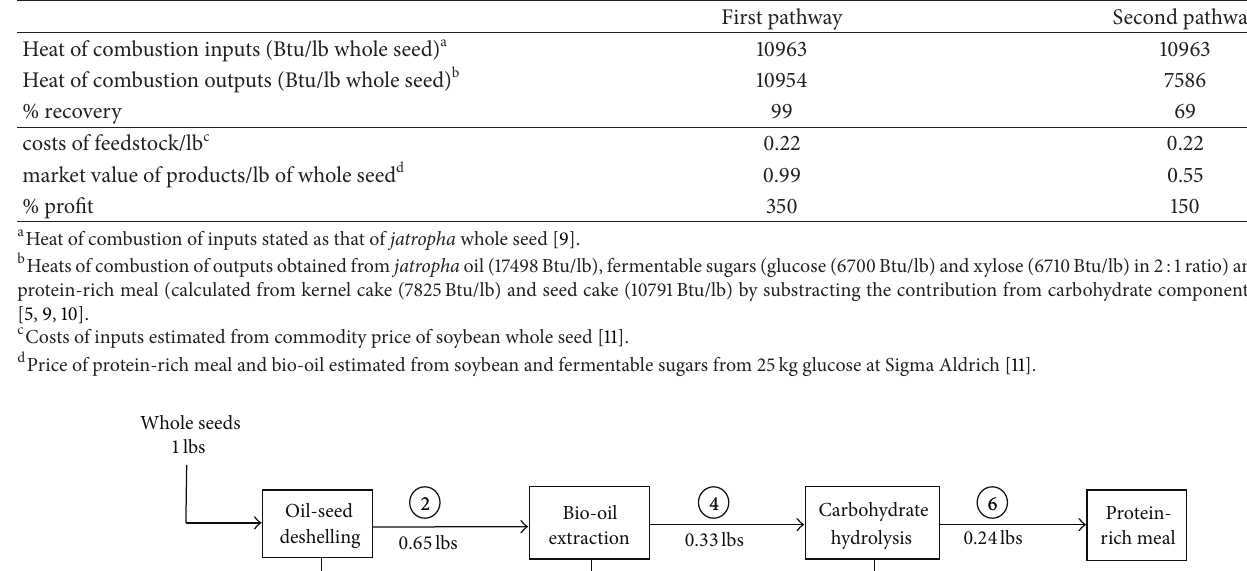
Table 6: Energy and price balances from jatropha whole seed processing using first and second pathways.